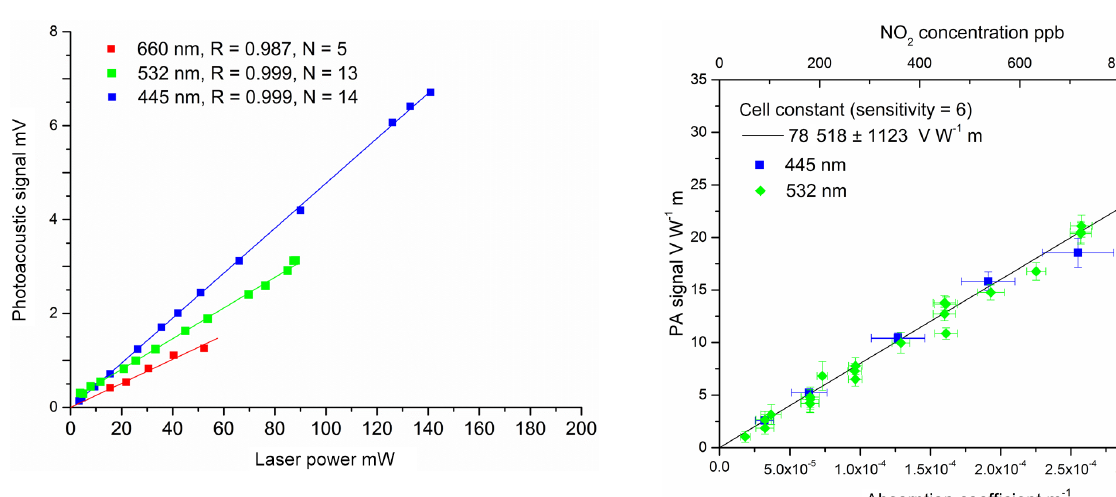
Figure 2. Test of the linearity response of the photoacoustic detec- tion system with laser power.